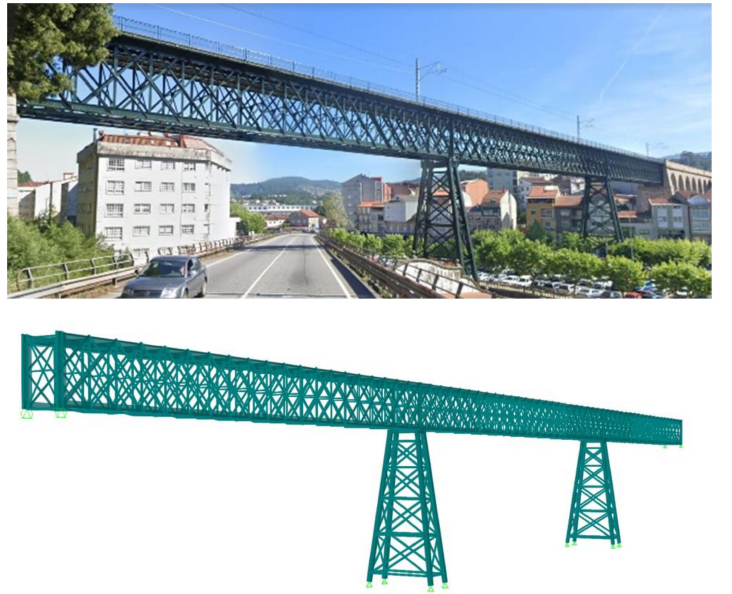
Figure 3. General view of Redondela Bridge and 3D numerical model using SAP2000 ®